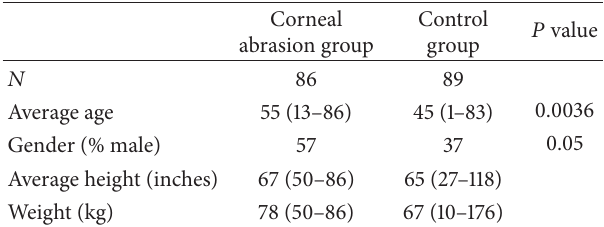
Table 1: Patient